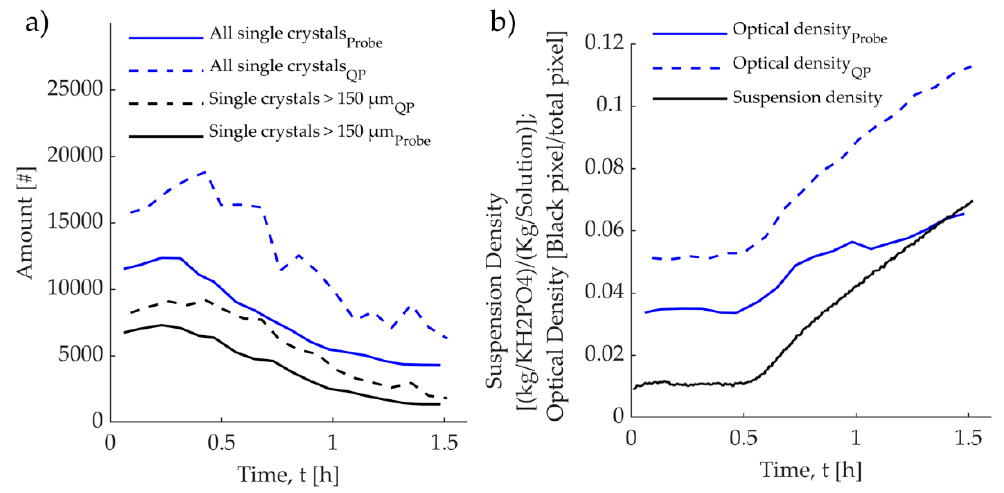
Figure 9. ( a ) Quantity of single crystals analyzed ( b ) the optical and suspension densities during experiment Exp. 3—KH 2 PO 4 .